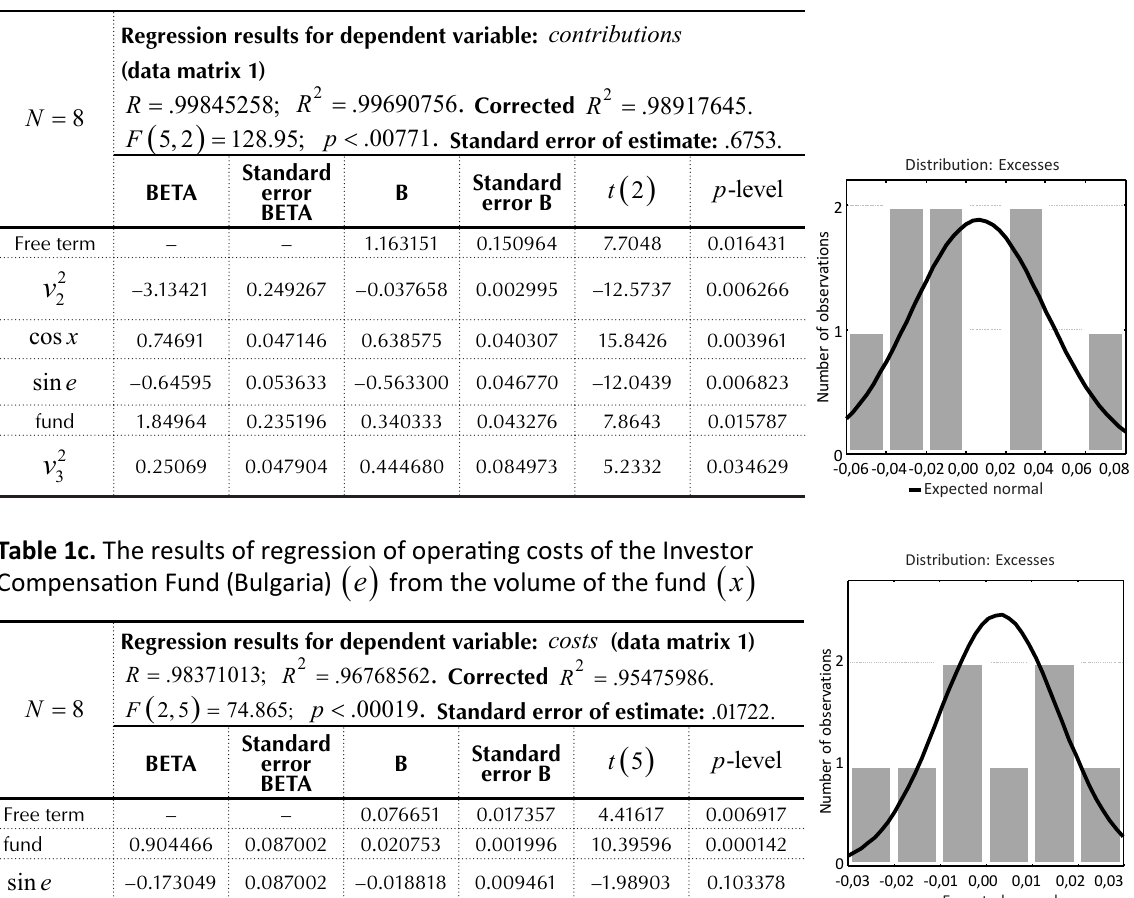
Table 1b. The results of regression of contributions from the members of the Investor Compensation Fund (Bulgaria) ( ) c from its volume ( ) x